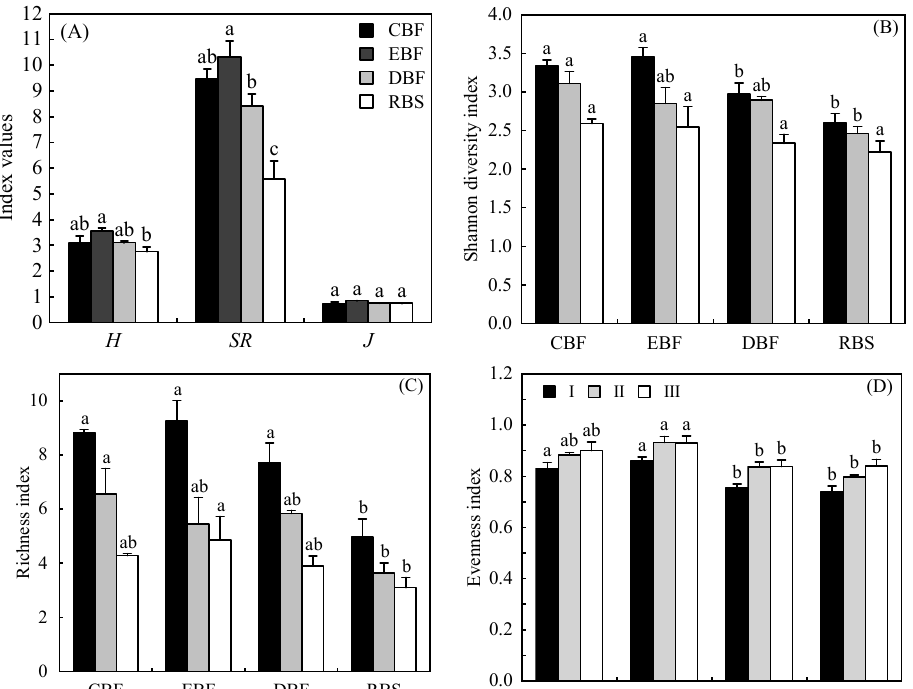
Figure 3. The horizontal ( A ) and vertical distribution ( B – D ) of the Shannon diversity index ( H ), Margalef richness index ( SR ), and Pielou evenness index ( J ) of soil mites in the study area. Note: Different lowercase letters indicate significant differences between vegetation types for each parameter of community diversity ( p < 0.05).